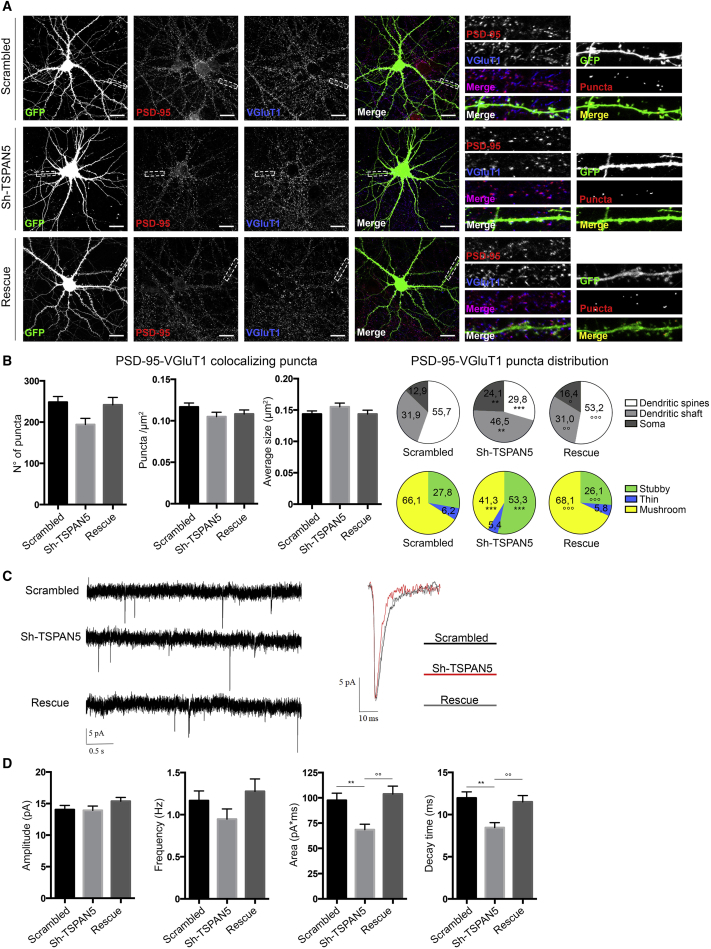
TSPAN5 Depletion Does Not Affect Excitatory Synapse Function(A) Confocal images of DIV 18 rat hippocampal cultured neurons transfected at DIV 5 with scrambled, Sh-TSPAN5, or rescue constructs all co-expressing GFP and immunolabeled for PSD-95 (red) and VGluT1 (blue). Insets show higher magnification of dendrites highlighted in white boxes and colocalizing puncta between PSD-95 and VGluT1 (cluster, red).(B) Quantification relative to (A) of PSD-95-VGluT1 colocalizing puncta in GFP positive areas (number of puncta), puncta density (puncta/square micrometer) and average size (square micrometers). Gray charts show percentage of puncta distributed among the dendritic spines (white), the dendritic shaft (light grey), and the soma (dark grey). Colored pie charts show the distribution of PSD-95-VGlut1 colocalizing puncta on different subtypes of dendritic spines (stubby, thin, and mushroom). n = 16 neurons/condition.(C) Representative traces of AMPAR-mediated mEPSCs recorded from DIV 18 rat hippocampal cultured neurons transfected at DIV 5 with scrambled, Sh-TSPAN5, or rescue constructs. Scrambled, n = 24; Sh-TSPAN5, n = 25; rescue, n = 19.(D) Quantification of amplitude, frequency, area, and decay time of AMPAR-mediated mEPSCs relative to (C).Exact values are shown in Table S1. See also Figure S2. Graphs represent mean ± SEM. ∗p < 0.05, ∗∗p < 0.01, and ∗∗∗p < 0.001 versus scrambled; °p < 0.05, °p < 0.01, and °p < 0.001 versus Sh-TSPAN5.